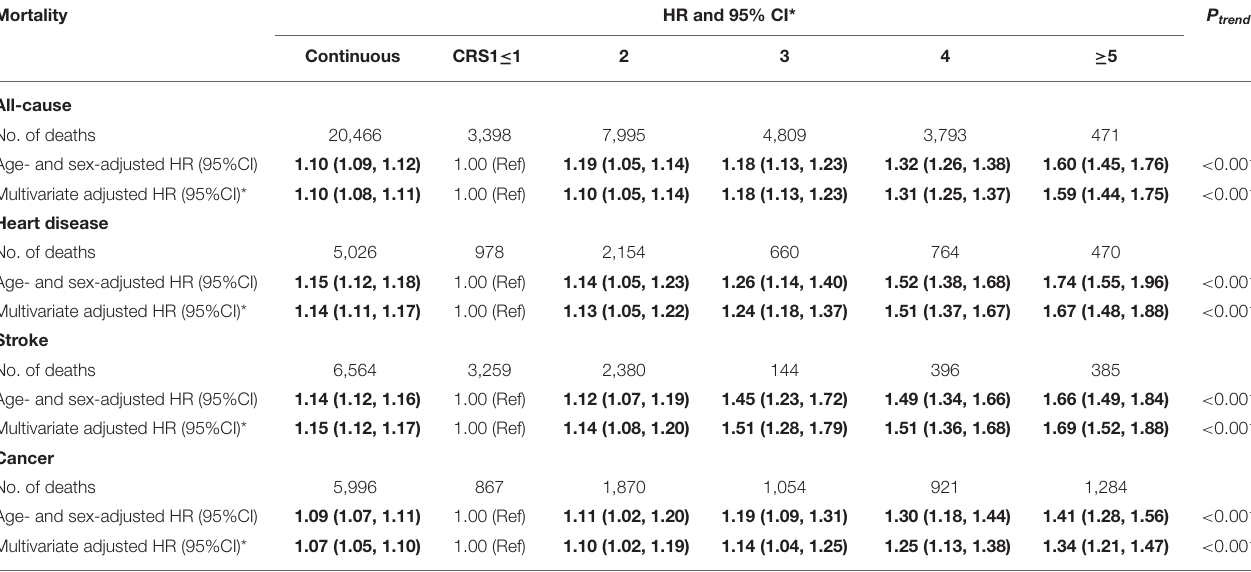
TABLE 3 | HRs and 95% CIs for the associations between CRS 1 and risk of all-cause and cause-specific